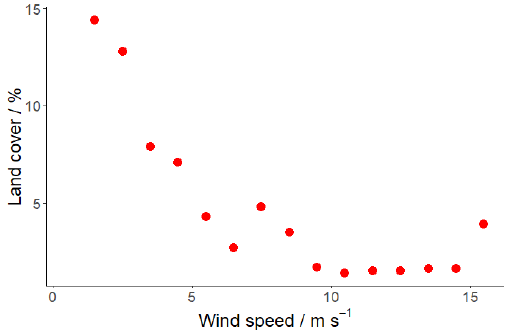
Figure 4. Land cover percentage within the average flux foot- print for 1ms − 1 wind speed bins as calculated with the Kljun et al. (2015) flux footprint parameterisation. The presence of land within the footprint area was greater during periods of low wind speed and atmospheric